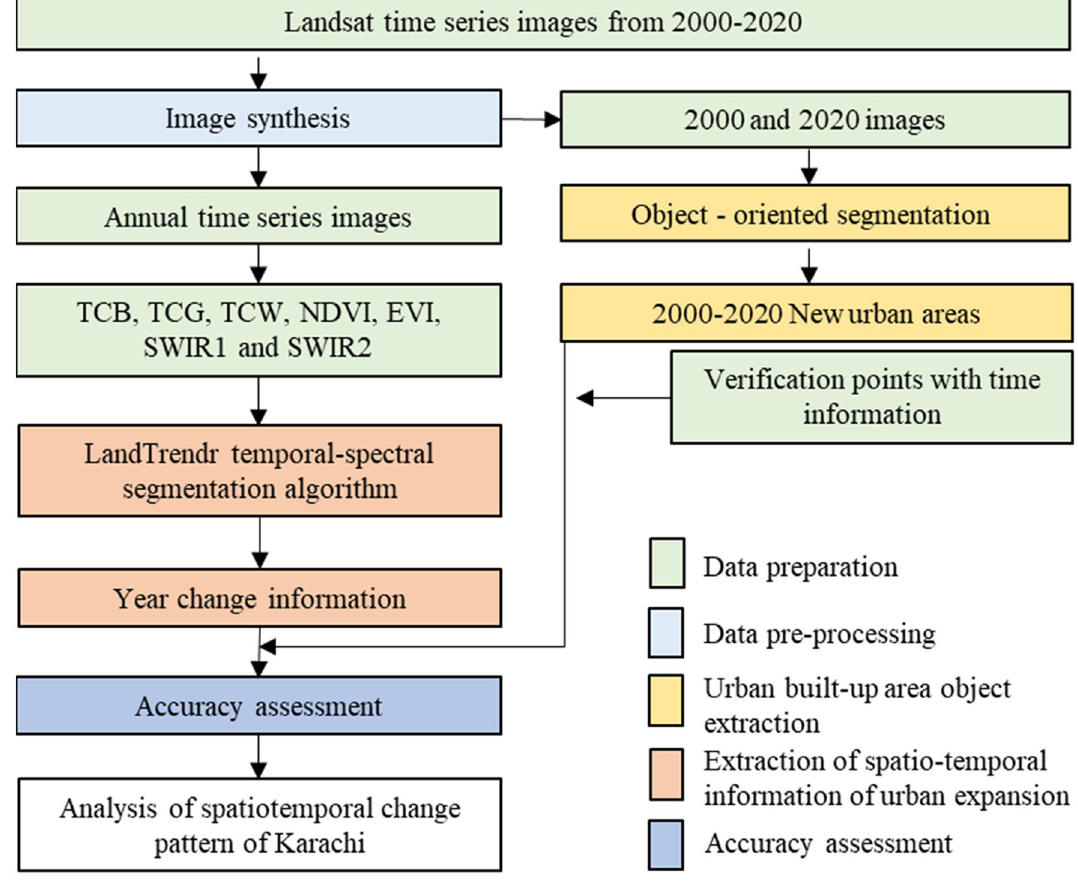
Figure 11. Flowchart of urban expansion